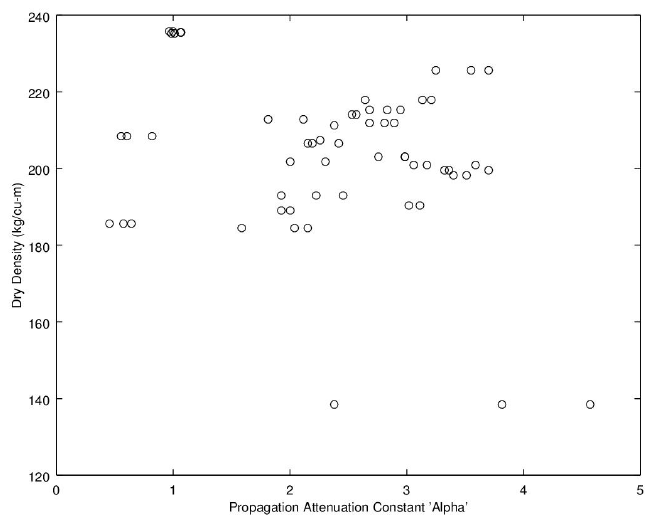
Figure 11. Propagation attenuation constant, α , versus bulk dry density (no water) at 1.0 GHz.